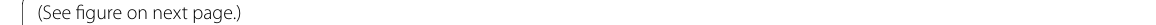
Fig. 1 The specificity of antibodies against Imp and detection of ROLP infection in rice tissues. a Schematic illustration of the peptide design of Imp (17 kDa). Western blotting analyses showing specificity of antibodies of Imp2, Imp4, and Imp5. Total proteins from E. coli strain expressing Imp, ROLP-infected or healthy leafhopper, or ROLP-infected or healthy rice were separated by SDS-PAGE. b Immunofluorescence micrographs showing the distribution of ROLPs in the phloem of rice leaves with typical ROLD symptoms. Frozen slices from healthy or ROLP-infected rice tissues were immunolabeled with Imp-specific antibody directly conjugated with rhodamine (Imp-rhodamine, red) and then examined by immunofluorescence microscopy. Ve, vessel; ST, sieve tube. Scale bars, 20 μm. c Electron micrographs showing the distribution of ROLPs in the vascular bundles of ROLP-infected rice leaves. Panel i, phloem cells of ROLP-infected rice leaves. Panel ii is the enlarged image of the boxed area in panel i, showing ROLP-infected companion cells. Scale bars, 10 μm (i) and 500 nm (ii) d Electron micrographs of ROLP-infected sieve tube cells of rice. Panels II–VII are the enlarged images of the ROLP-infected cells in panel I. Panels IV–VII, morphologically different small virus-like particles which were specifically labeled by gold particles. Mes, mesophyll; PP, phloem parenchyma; SE, sieve elements; ST, sieve tube; Ve, vessel. Scale bars, 500 nm (i) and 60